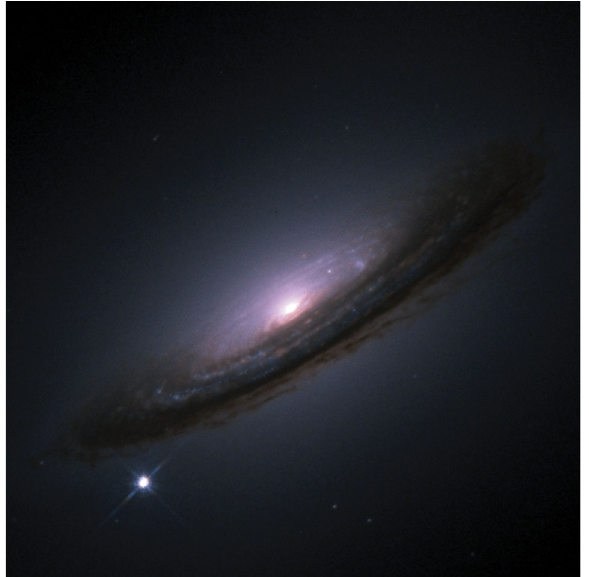
FIG. 5. Image of the galaxy NGC 4526, showing SN1994D (SN short for Supernova). Type 1a supernovae, which are a particular class of exploding stars, are key to measuring extreme distances in cosmology. They were also key in working out that the Universe on the large scale is undergoing accelerated expansion. Image credit: NASA/ESA, The Hubble Key Project Team and The High-Z Supernova Search Team.